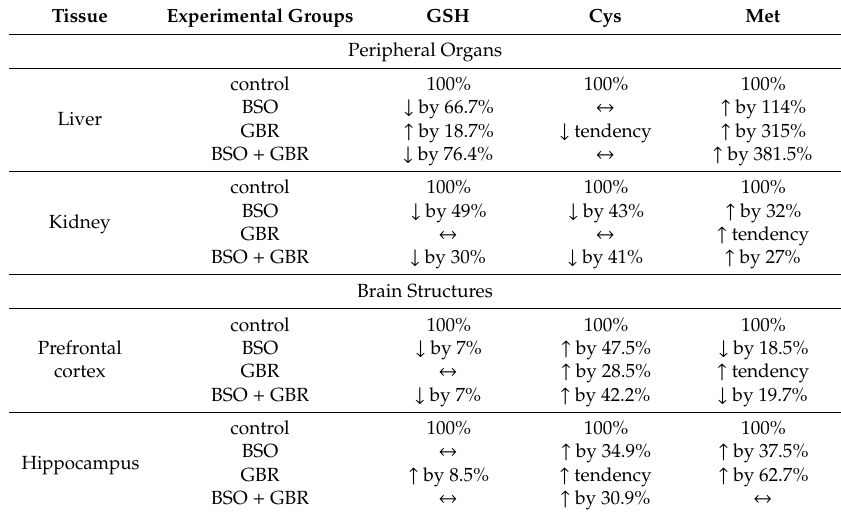
100% ↑ by 114% ↑ by 315% ↑ by 381.5% 100% ↑ by 32% ↑ tendency ↑ by 27% 100% ↓ by 18.5% ↑ tendency ↓ by 19.7% 100% ↑ by 37.5% ↑ by 62.7%